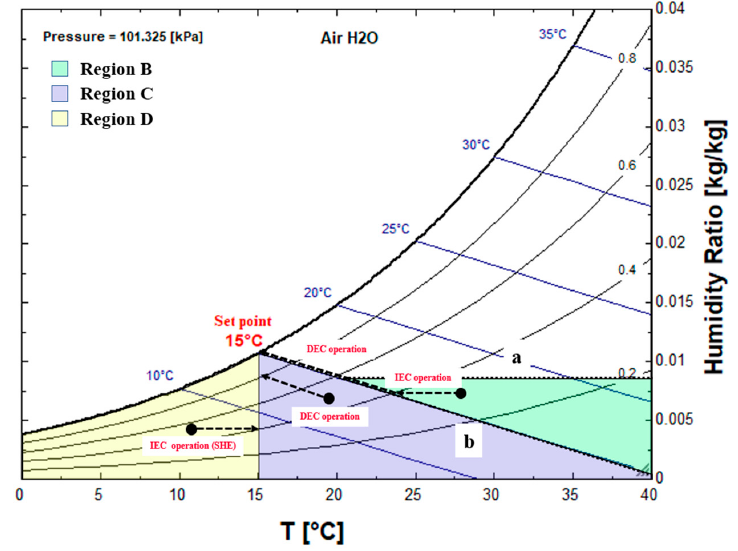
Figure 3. The operating processes B, C, and D of the LD-IDECOAS.